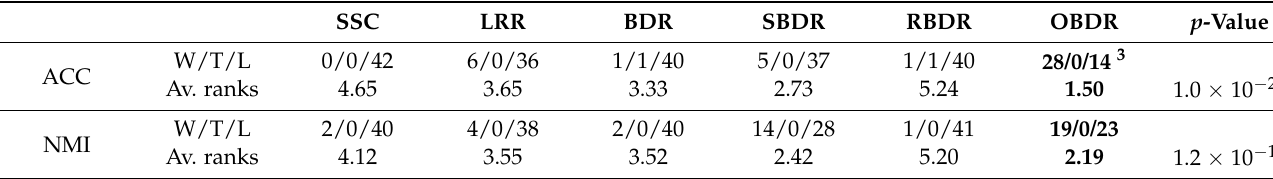
Table 5. W/T/L, average ranks and p